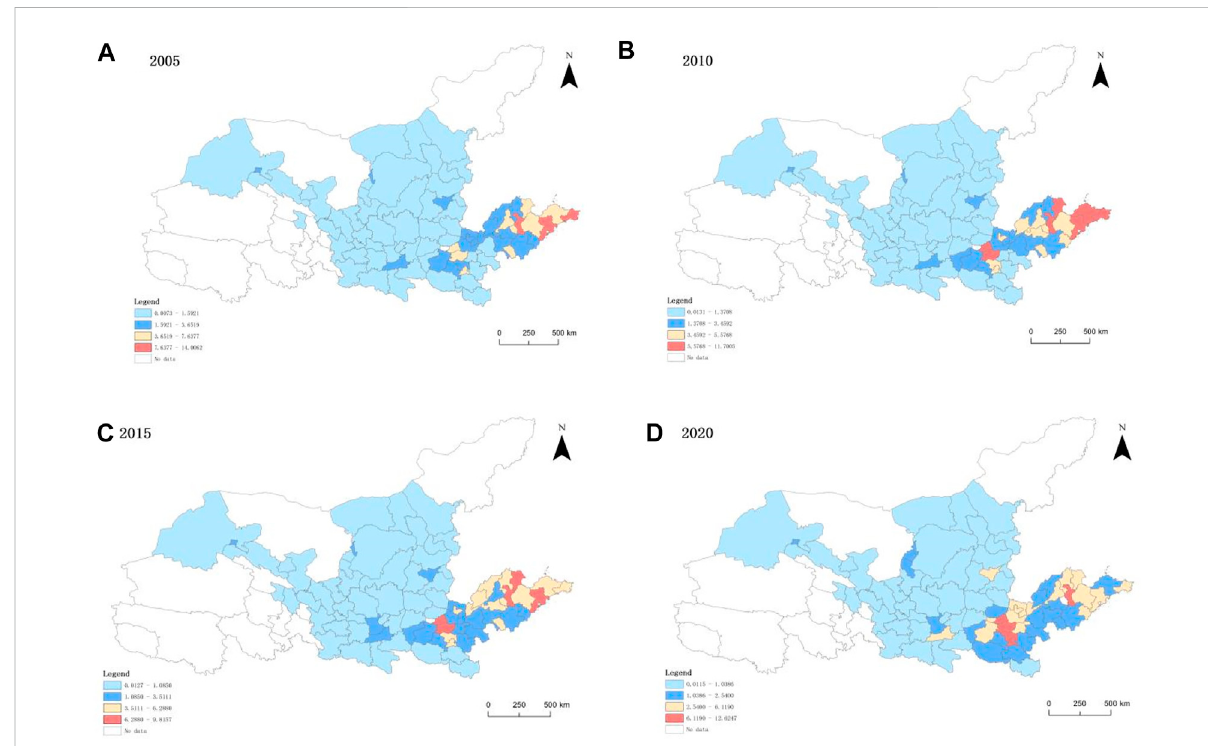
FIGURE 2 Spatial pattern of industrial agglomeration in the Yellow River Basin in 2005, 2010, 2015,